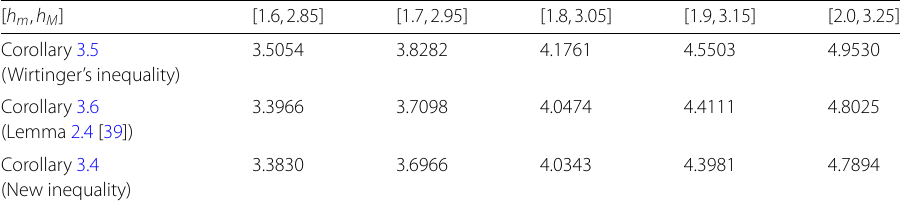
Table 8 MALBs of c 2 for T = 30, (cid:9) = 0.45 and different values of [ h m , h M ] ( h Mm = 1.25) in Example 4.2 (Case